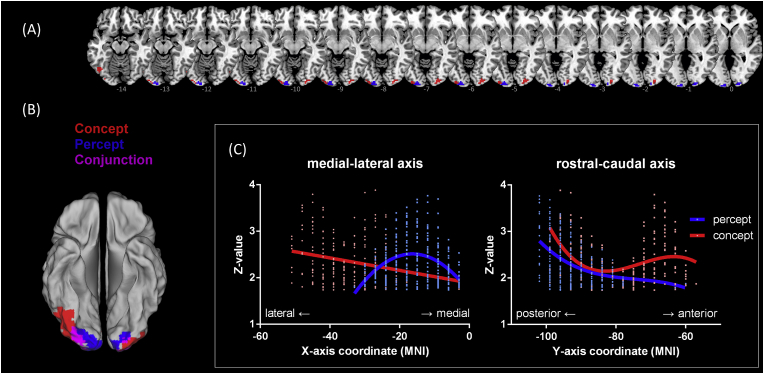
(A) Views of axial slices displaying percept vs. concept voxels, ranging from z = −14 to 0 (MNI). The occipitotemporal regions significantly more active for colour percept are shown in blue (localiser task: coloured > greyscale), more active for colour concept are show in red (main tasks: colour pairing > semantic pairing), and their overlaps are in magenta. Statistics are thresholded at p < .005 for voxel intensity and further constrained at least 270 mm3 for cluster size. (B) For illustration purposes only to show the cortical layout of ‘percept vs. concept’ areas, active clusters are rendered on an inflated template, thresholded at p < .05. (C) Mean-corrected activation level (Z-statistics) of occipital voxels as a functional of triggering stimuli (percept, concept) and location along the x- and y-axis, with the polynomial regression best-fitting lines representing trends.